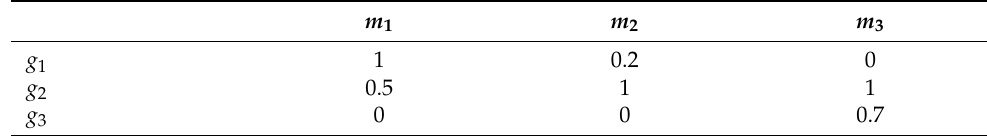
Table 1. Formal context for the